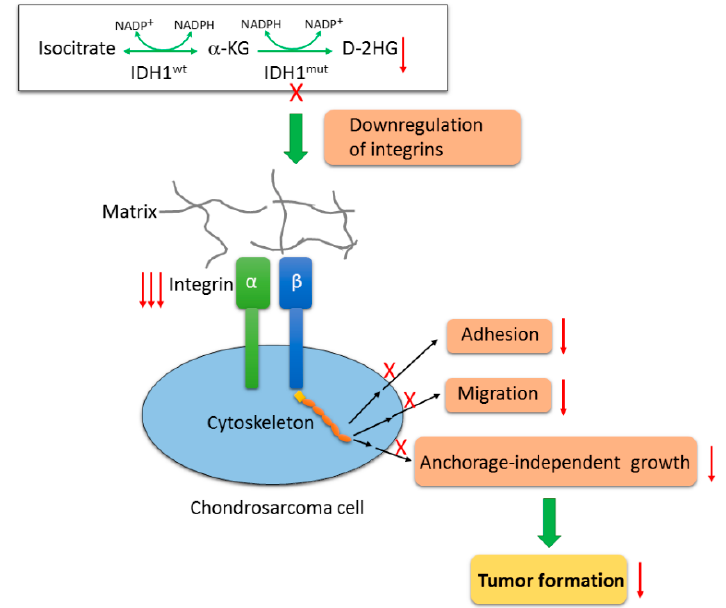
Figure 7. Proposed model of mutant IDH1 function in chondrosarcoma cells. Wildtype IDH enzymes catalyze the oxidative decarboxylation of isocitrate to form α -KG. IDH mutation confers on the mutant proteins a neomorphic activity by reducing α -KG into an oncometabolite, D-2HG. Inactivation of IDH1 mut by CRISPR/Cas9 technique nearly depleted D-2HG production, and subsequently attenuated the tumorigenicity of chondrosarcoma cells such as cell adhesion, cell migration and anchorage-independent growth, and impaired tumorigenic growth in vivo. This is achieved at least partially by the interruption of integrin-mediated cell-matrix interactions as a result of a wide downregulation of integrin genes upon loss of IDH1 mut .